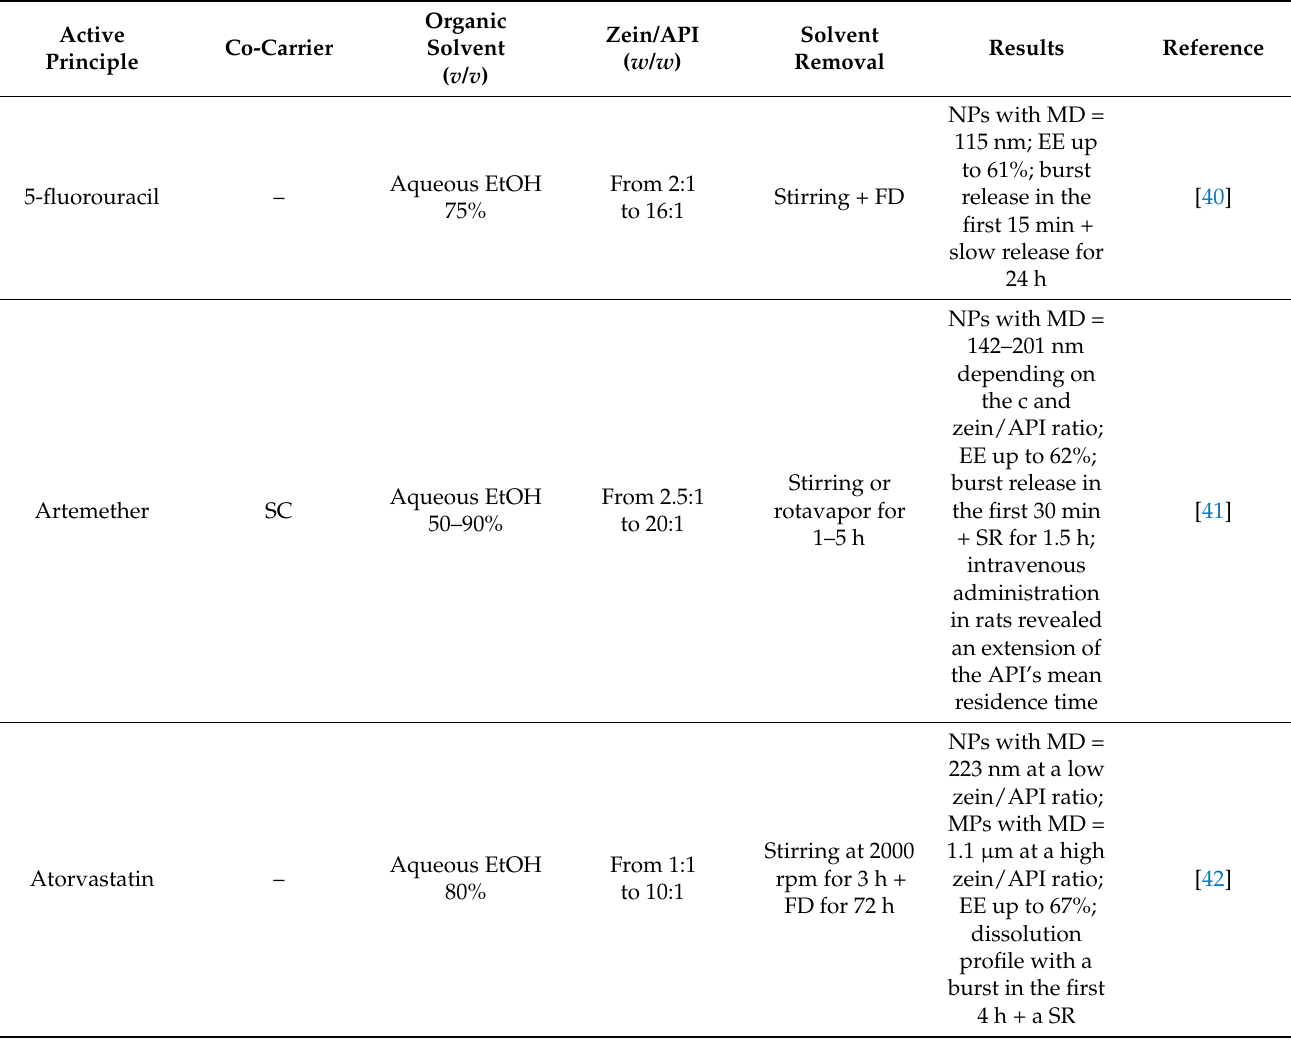
Table 1. Zein-based particles obtained using the liquid antisolvent process. AS/S, antisolvent/solvent; ATRA, all-trans-retinoic acid; β -CD, beta-cyclodextrin; Bor, bortezomib; BSA, bovine serum albumin; c, concentration in the liquid solution; C-28, human chondrocyte cells; CA, caffeic acid; Caco-2, human colon carcinoma cells; CS, chondroitin sulfate; CSA, carboxymethylated short-chain amylose; DOX, doxorubicin; DPPH, 2,2-diphenyl-1-picrylhydrazyl; DU145, prostate cancer cells; EC, ethyl cellulose; EE, encapsulation efficiency; EGCG, epigallocatechin gallate; ESP, ethanol-soluble polysaccharide; EtOH, ethanol; FA, folic acid; FD, freeze-drying; GA, gum arabic; GI, gastrointestinal; GLI, gliben- clamide; Glim, glimepiride; GNA, gambogenic acid; GT, poly(anhydride)-thiamine conjugate; HA, hydroxyapatite; HAc, hyaluronic acid; HACAT, immortalized human keratinocyte cells; HeLa, highly stabilized immortalized tumor cells; HepG2, human liver cancer cells; HP- β -CD, 2-hydroxypropyl- beta-cyclodextrin; HT29, human colorectal adenocarcinoma cells; HT29-MTX, human colon cancer cells; Hya, hyaluronan; Indo, indomethacin; K562, chronic myelogenous leukemia cells; mPEG, methoxy poly(ethylene glycol); MCF-7, human breast cancer cells; MD, mean diameter; MP, micropar- ticles; MW, molecular weight; NCTC2544, human keratinocyte cells; Nic, niclosamide; NCI/ADR- RES, ovarian tumor cells; NP, nanoparticles; PC3, prostate cancer cells; PDA, polydopamine; PEG, poly(ethylene glycol) 2000; PGA, propylene glycol alginate; PL, polydopamine–lecithin; PNS, Panax notoginseng saponins ; PSA, polysialic acid; PTS, pterostilbene; Que, quercetagetin; Res, resveratrol; SC, sodium caseinate; SD, spray-drying; SGF, simulated gastric fluid; SIF, simulated intestinal fluid; SR, sustained release; Suc, succinic anhydride; SW480, colon cancer cells; T, temperature; Toc, tocopherol; TS, tea saponin; Vor, vorinostat; XG, xanthan gum; 4T1, mammary carcinoma cells; A549, human lung carcinoma